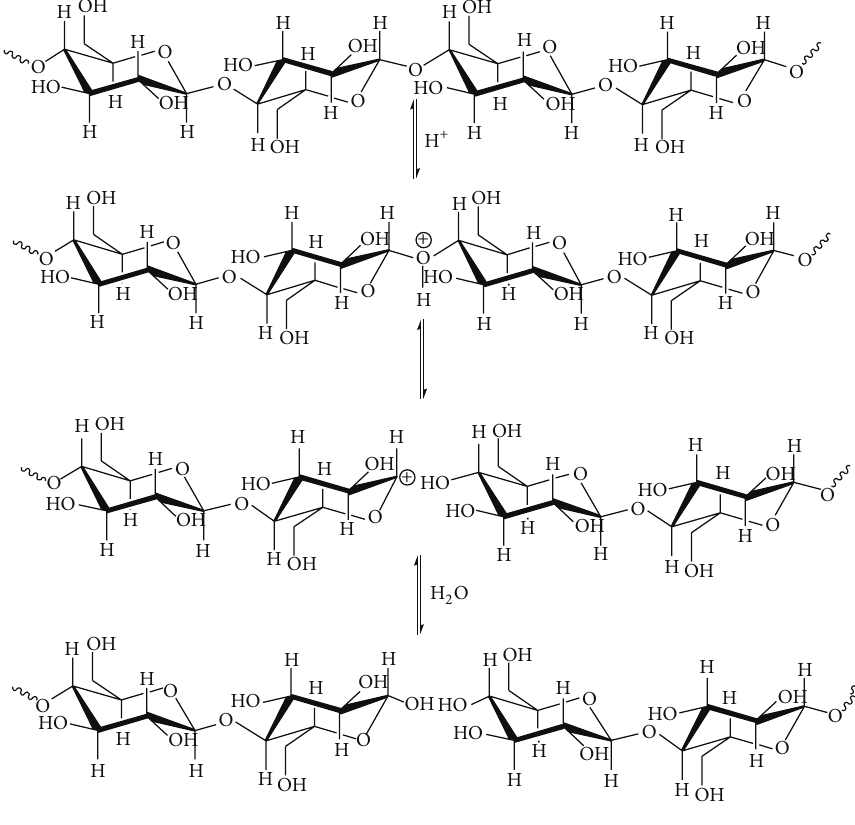
Figure 9: Acid hydrolysis of cellulose in to nanocellulose.